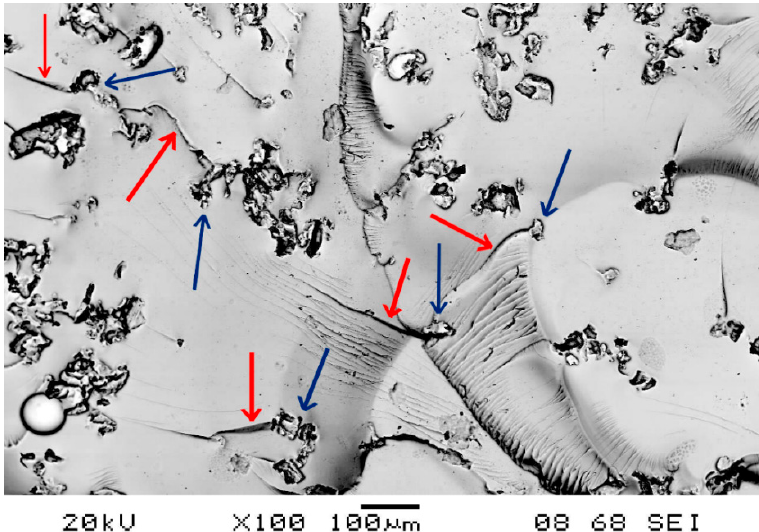
Figure 10. Crack propagation inside rubber-filled EP resin (RPs are indicated by the blue arrows, cracks are indicated by the red arrows).